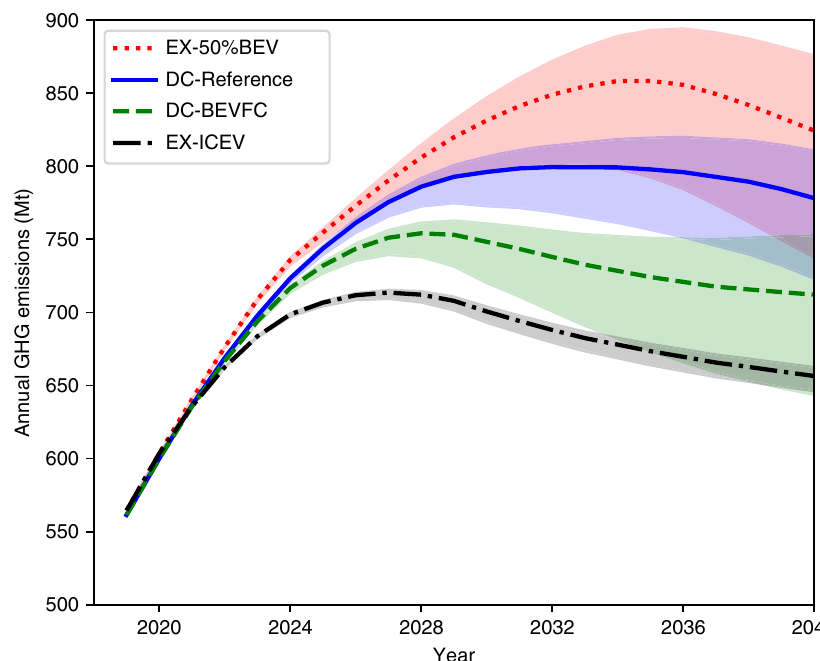
Fig. 4 Uncertainties of annual life-cycle GHG emissions of the LDPV fl eet in China due to the electricity GHG intensity. EX-50%BEV: extreme scenario with 50% BEV sales share by 2030; DC-Reference: Dual Credit policy reference scenario; PT-BEVFC: policy tweak by setting non-zero FC for NEVs in the CAFC standards; EX-ICEV: extreme scenario by aggressively improving ICEV ef fi ciency. The shaded area represents the uncertainties due to the GHG intensity of the Chinese electric grid.